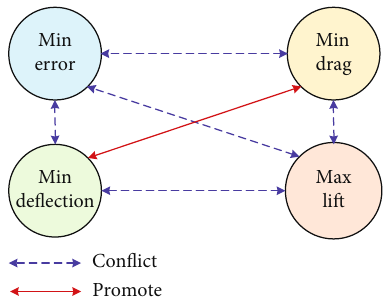
Figure 7: Qualitative relationship between some secondary objectives.